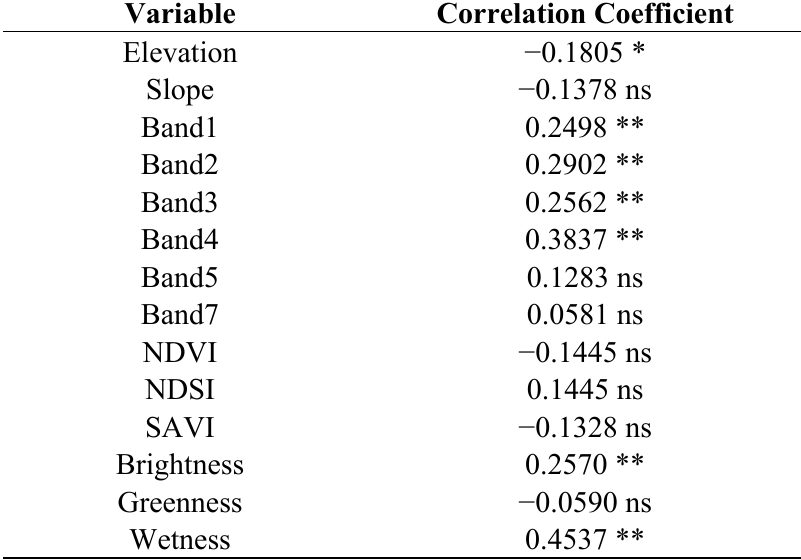
Table 4. Correlation between EC values and numerical environmental